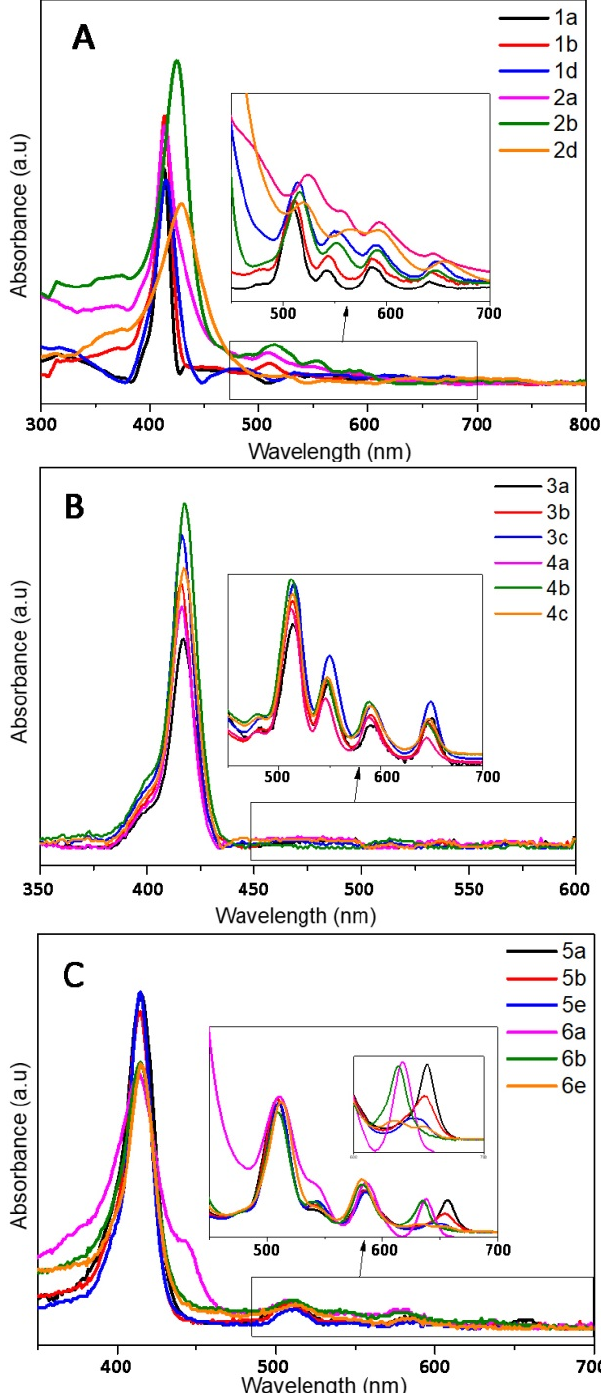
Figure 3. Absorption spectra of the different porphyrins in ethanol: ( A ) 1 and 2 , ( B ) 3 and 4 , ( C ) 5 and 6 .